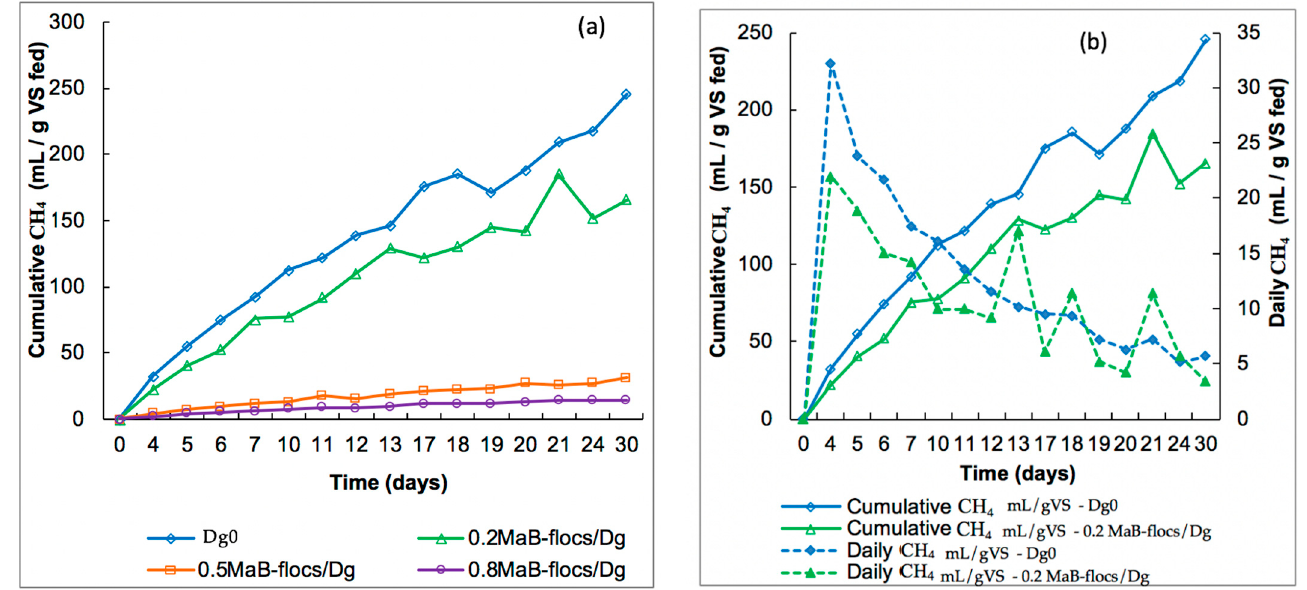
Figure 4. ( a ) Cumulative methane production for digestate control (Dg 0) and different ratios of Ma-B flocs /Digestate (Ma-B flocs/Dg). ( b ) Daily and cumulative methane production for digestate control (Dg0) and ratio 0.2 Ma-B flocs /Digestate.